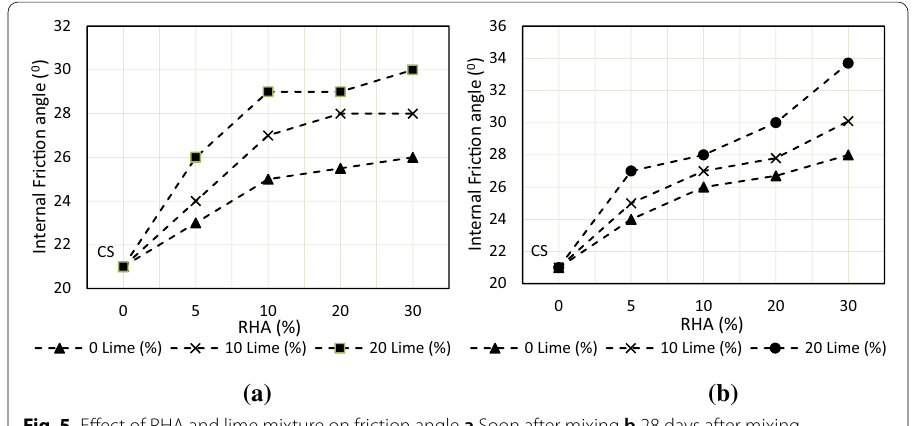
Fig. 5 Effect of RHA and lime mixture on friction angle a Soon after mixing b 28 days after